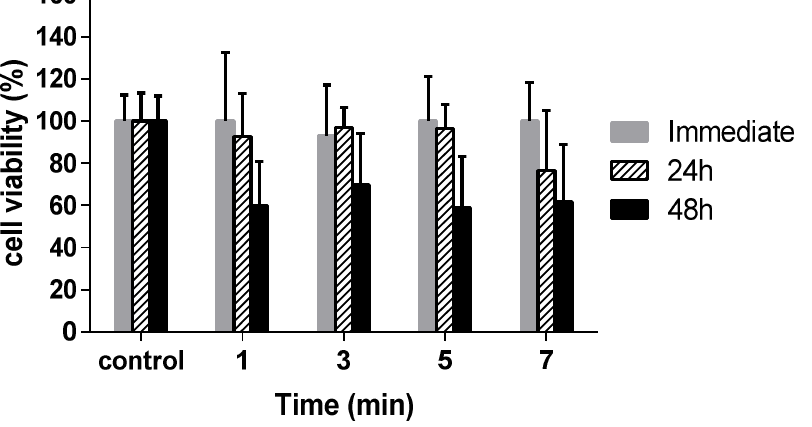
Figure 4. Cytotoxicity analysis of non-thermal plasma at atmospheric pressure expressed in cell viability. The 3T3 cells were exposed to CAP for 1, 3, 5 and 7 min. The cell viability was determined immediately (gray bar), 24 h (striped bar) and 48 h (black bar) after plasma exposure.